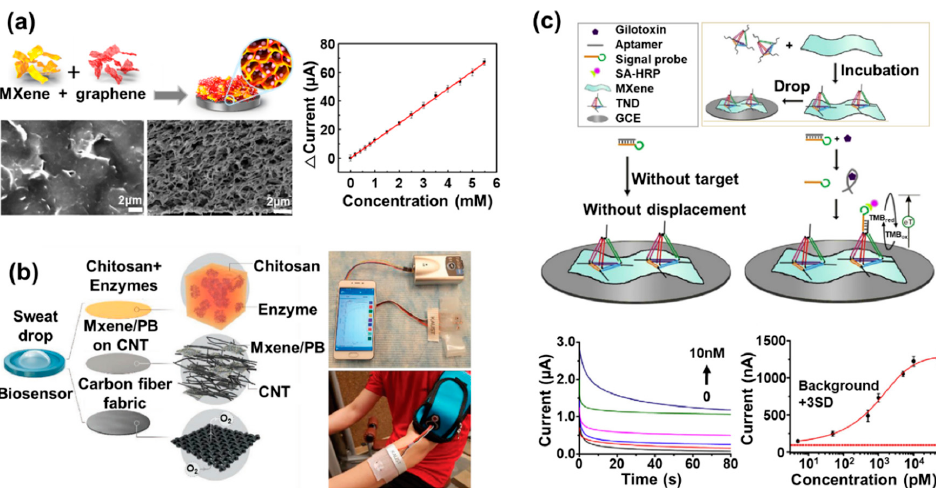
Figure 3. MXene-based electrochemical biosensors. ( a ) Construction of the MXene (Ti 3 C 2 T x ) and graphene hybrid film (MG hybrid film): the SEM and cross-sectional images of the MG hybrid film, and the calibration plot of current versus different concentrations of the glucose obtained by using the MG hybrid film-based glucose biosensor (reprinted with permission from [51]; copyright (2019) American Chemical Society). ( b ) Schematic image of the sensing probe electrode in the wearable biosensing system based on the MXene/Prussian blue composite, and the optical image of the wearable electrochemical multifunctional biosensing patch system connected to the portable device and human body (reprinted with permission from [52]; copyright (2019) John Wiley and Sons, Inc.). ( c ) Schematic diagram of the label-free electrochemical gliotoxin biosensor based on the nanocomplexes composed of the tetrahedral DNA nanostructure (TDN), MXene nanosheet, and horseradish peroxidase (HRP); its sensing mechanism; and amperometric response curves, and the analyzed logarithmic plot for the detection of gliotoxin (reprinted with permission from [53]; copyright (2019) Elsevier publishing).